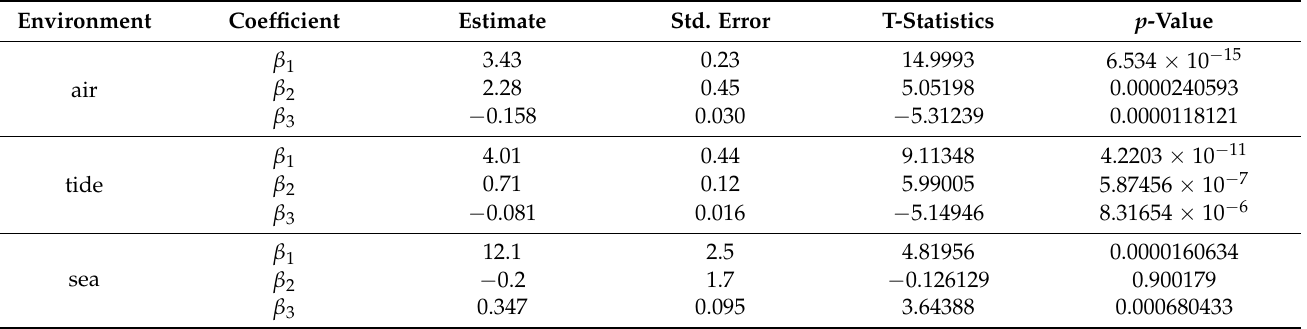
Table 4. The regression parameters of the three formed models for NiTi1 corrosion depth in the air, tides, and sea.